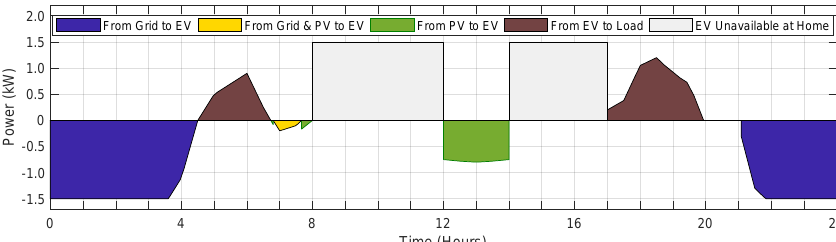
Figure 10. EV charging and discharging power profile when the proposed strategy is used for managing the energy in a smart home equipped with EV and